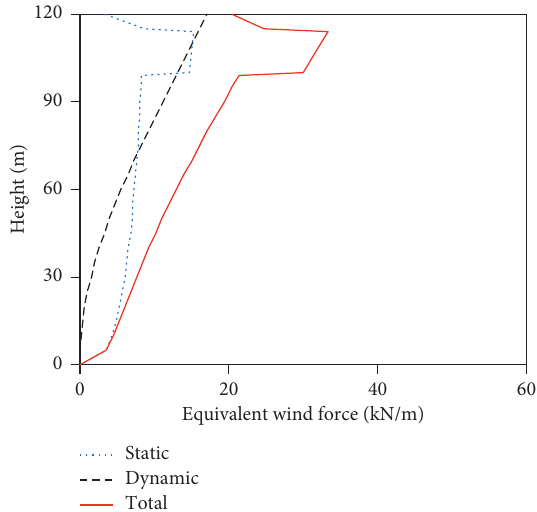
Figure 13: Along-wind equivalent wind forces evaluated from the aeroelastic model test.